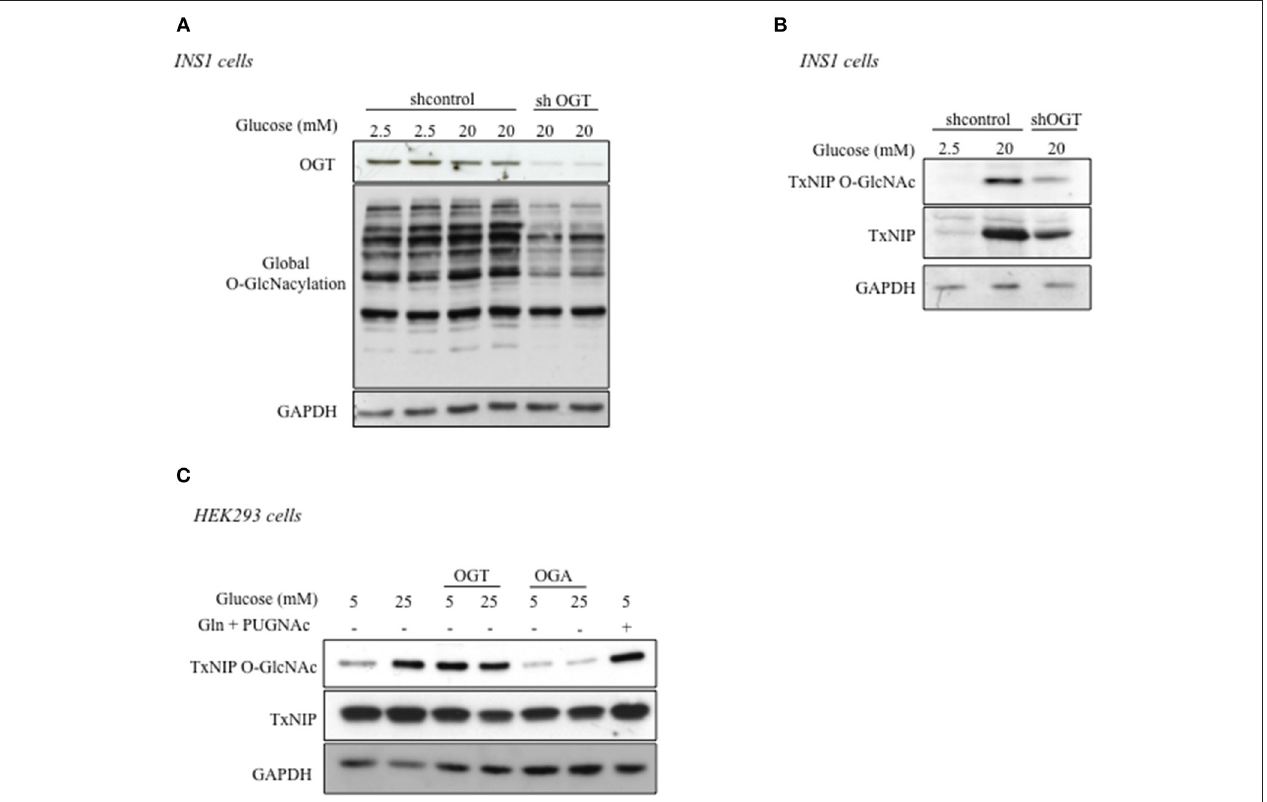
FIGURE 2 | TxNIP O-GlcNAcylation is dependent on OGT. (A,B) INS1 832/13 cells were infected by a shControl or shOGT adenovirus for 24h. INS1 832/13 cells were later stimulated for 24h under low glucose (2.5mM) or high glucose (20mM) concentrations. (A) Global O-GlcNAcylation levels and OGT protein content. GAPDH was used as a loading control. (B) TxNIP O-GlcNAcylation was evaluated by WGA binding experiments. Protein lysates from INS1 832/13 cells were immunoblotted with TxNIP and GAPDH was used as a loading control. (C) HEK293 cells were co-transfected with TxNIP, OGT, and OGA plasmids and incubated for 24h under low (5mM) or high glucose conditions (25mM) supplemented or not by PUGNAc and glucosamine (Gln). O-GlcNAcylation level of TxNIP was evaluated using an anti-O-GlcNAc antibody (RL2). Immunoprecipitation (IP) of TxNIP was analyzed by immunoblotting with a Flag antibody. Representative Western blot from n = 3 experiments for TxNIP protein content are shown. GAPDH was used as loading